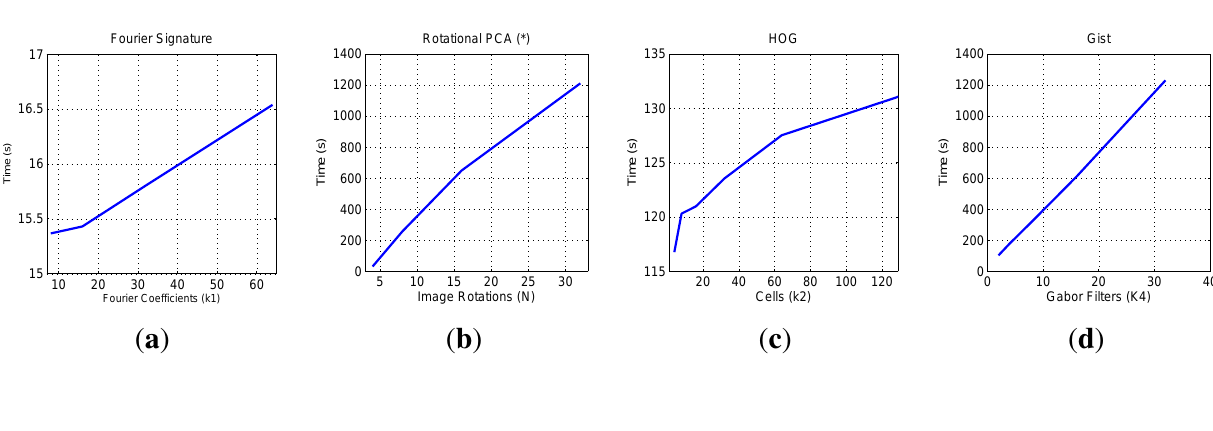
Figure 8. COLD database. Necessary memory to store the